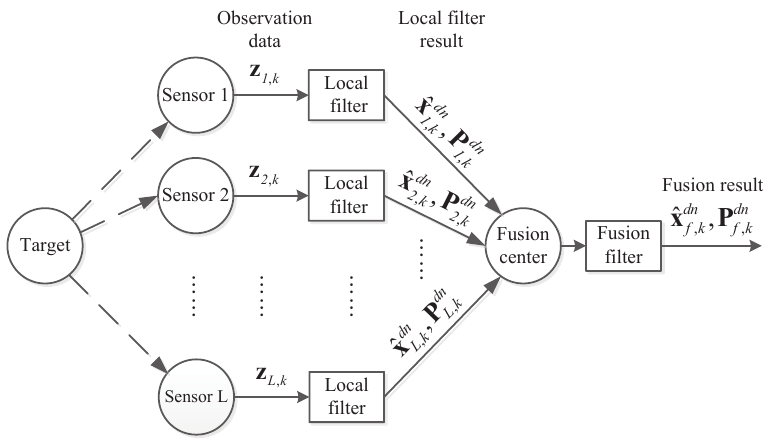
Figure 2. The process of distributed multi-sensor fusion system without feedback.